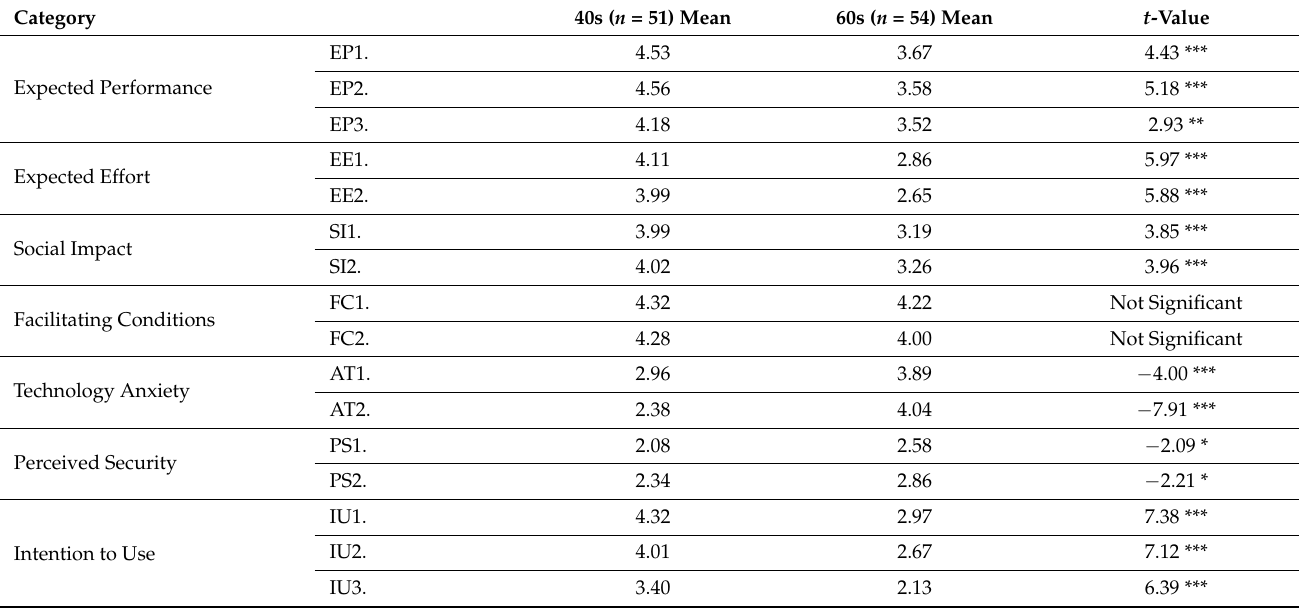
Figure 4. Smart Home Technology Acceptance by User Level (* p < 0.05, *** p < 0.001). Table 11. Smart Home Technology Acceptance by Age